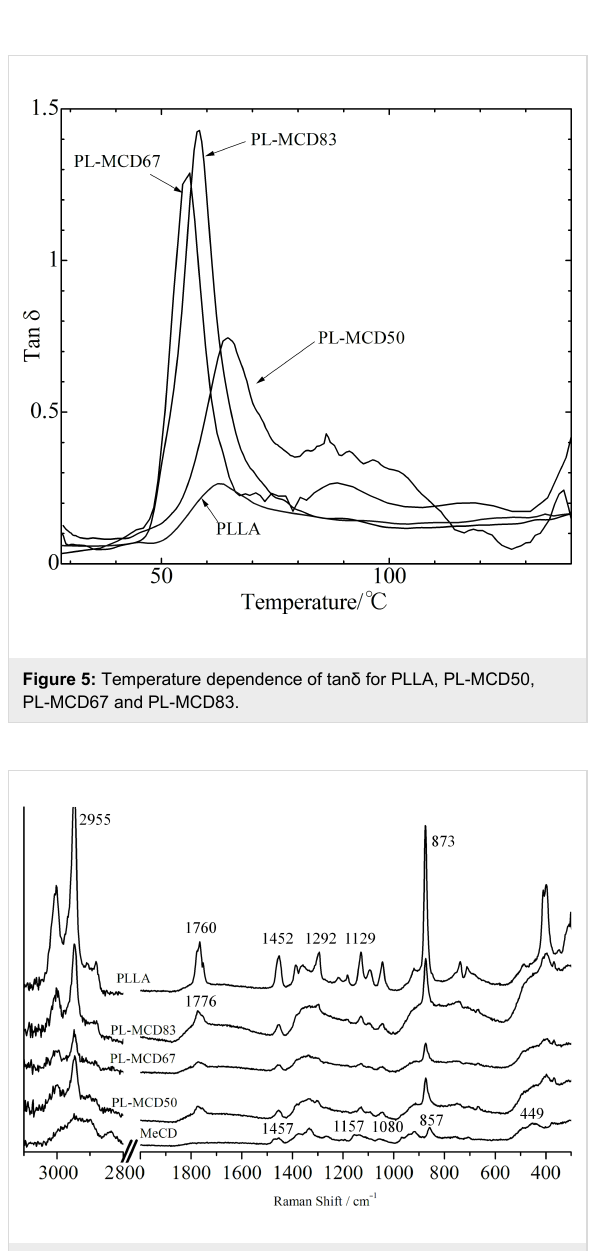
Figure 6: Raman spectra for PLLA, PL-MCD83, 67, 50 and MeCD at room temperature.